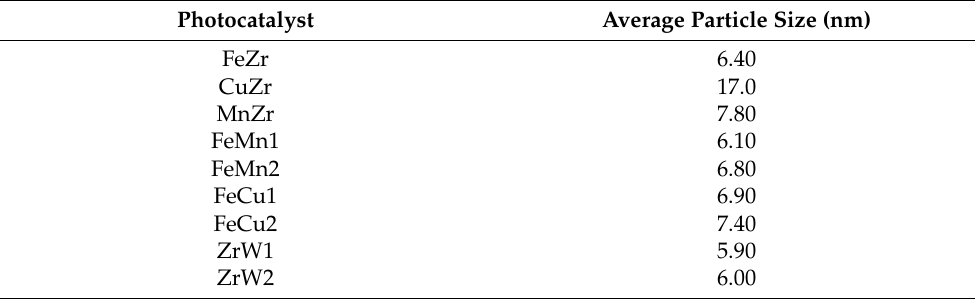
Table 2. Average particle size of the prepared nano